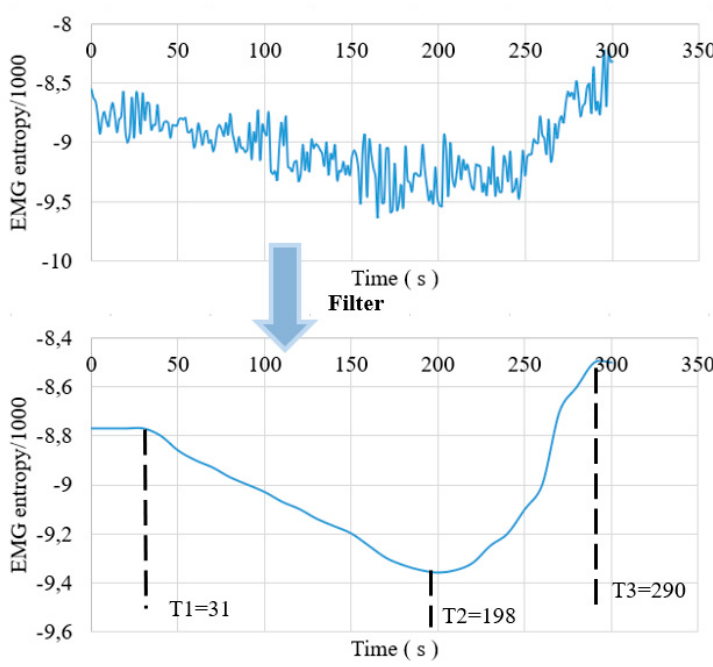
Figure 11. The EMG entropy of experimental data of subject A at 4.5 kg.